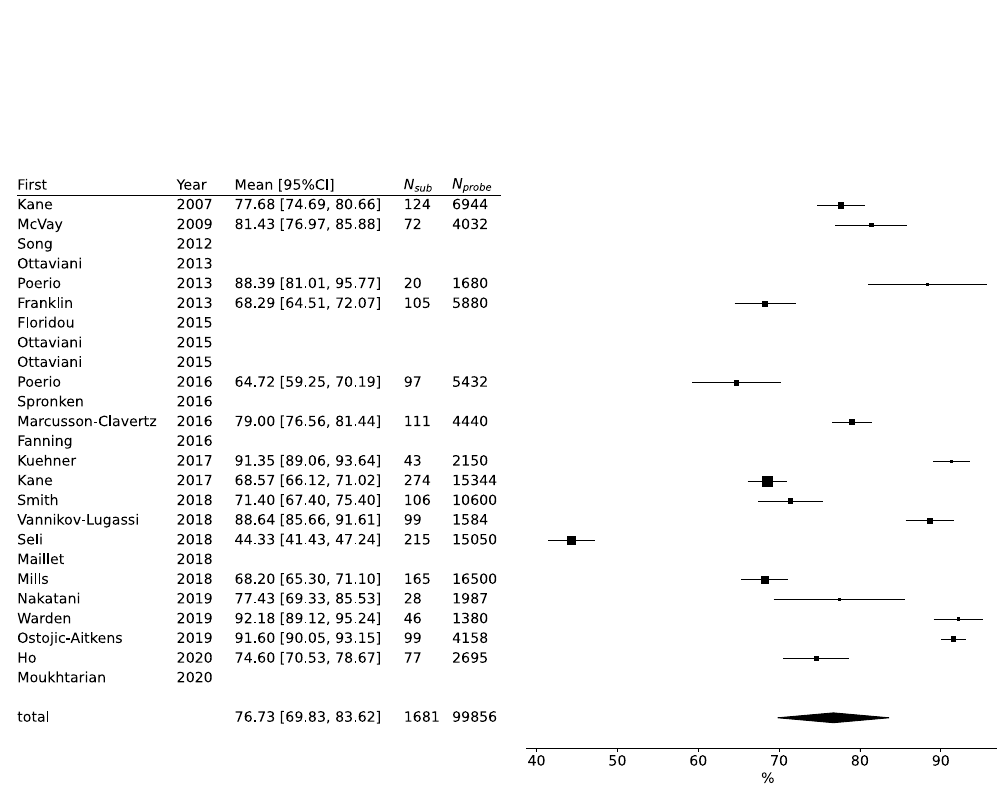
Figure 4. Forest plot of compliance rate. The effect size and corresponding bar are blank if the mean compliance rate was unavailable. First First author of studies, Year Year of publication, Mean [95%CI] Reported mean compliance rate and 95% confidence intervals, N sub Included number of subjects, N probe Included total number of